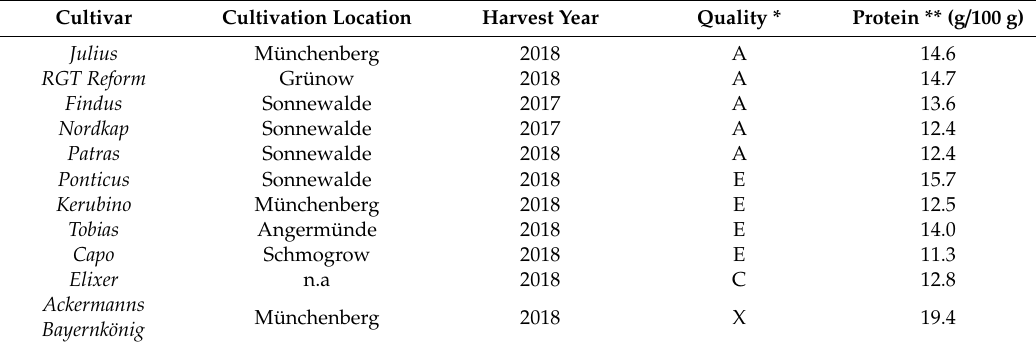
Table 1. Selected German wheat cultivars and their available data for the protein comparison. Cultivar